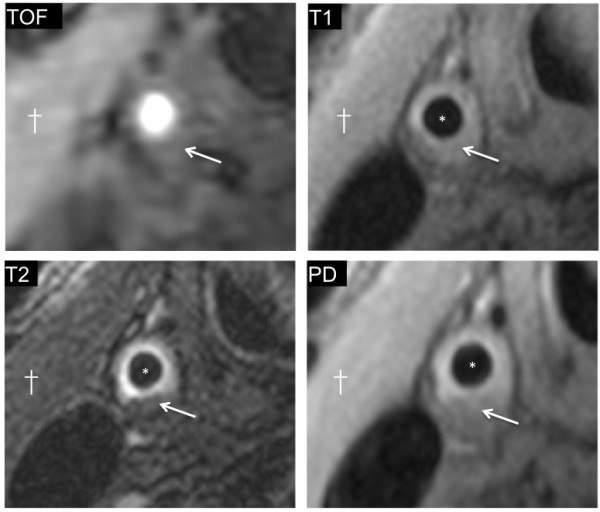
Example of restenosis with the appearances of lipid reaccumulation. 50% restenosis of the right common carotid artery is shown (*marks lumen). A crescent of plaque is seen that is isointense to the adjacent sternocleidomastoid muscle (†) on the T1W image (arrow). The same area shows low intensity signal on the T2W image (arrow), suggestive of lipid-rich plaque.